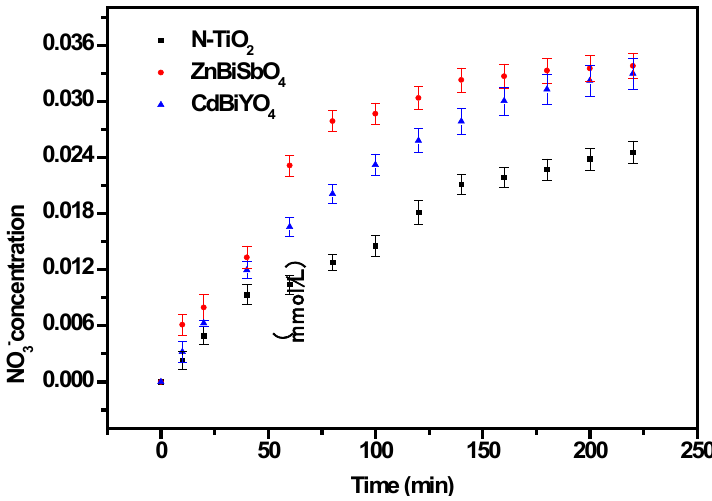
CdBiYO and N-TiO as photocatalysts, respectively, under visible light irradiation. 4 2 The results are means of triplicates, and error bars represent ±1